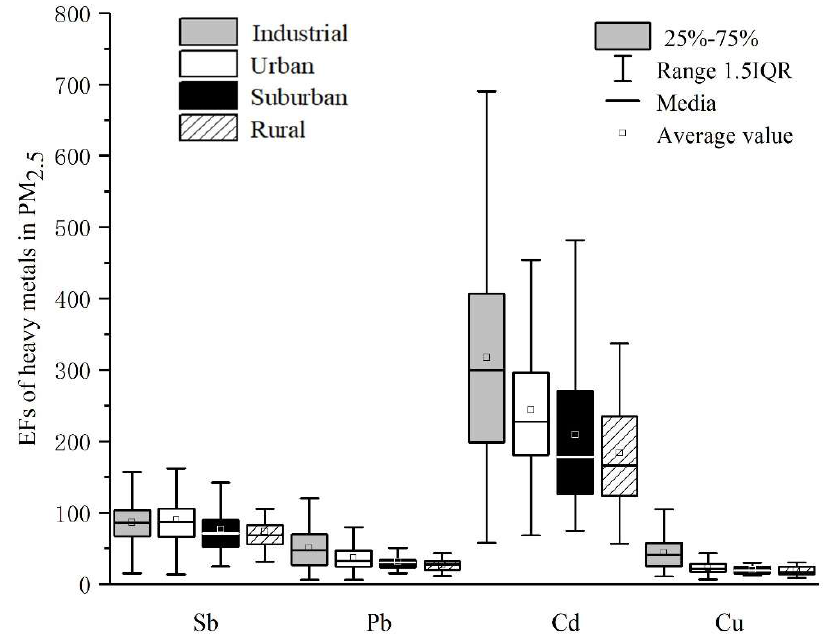
Figure 6. Comparison of the enrichment factors (EFs) of PM 2.5 -bound heavy metals (EF > 10) in air among four different functional regions in Nanjing city during 2016.